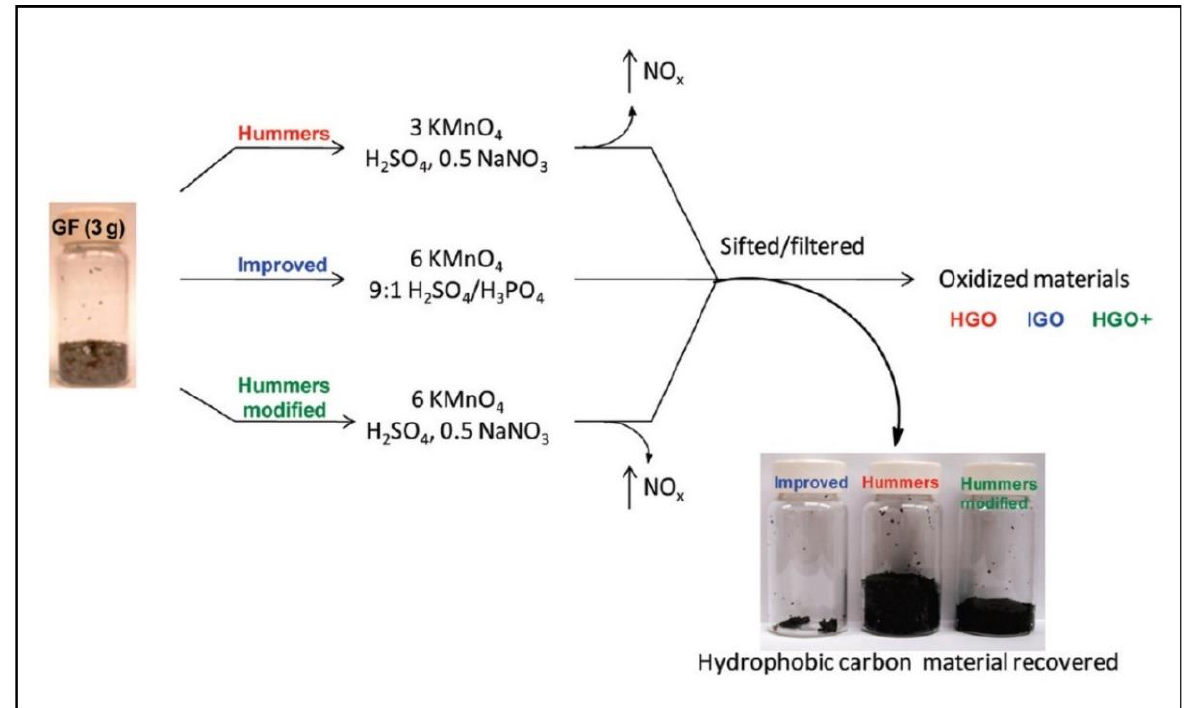
Figure 4. Flowsheet diagram for Tour ’ s method to produce graphene oxide. In this method, graphite serves as the starting material, which is then compared to Hummers and its modification. Displays a carbon source for GO synthesis from graphite. Reprinted with permission from Ref. [63].